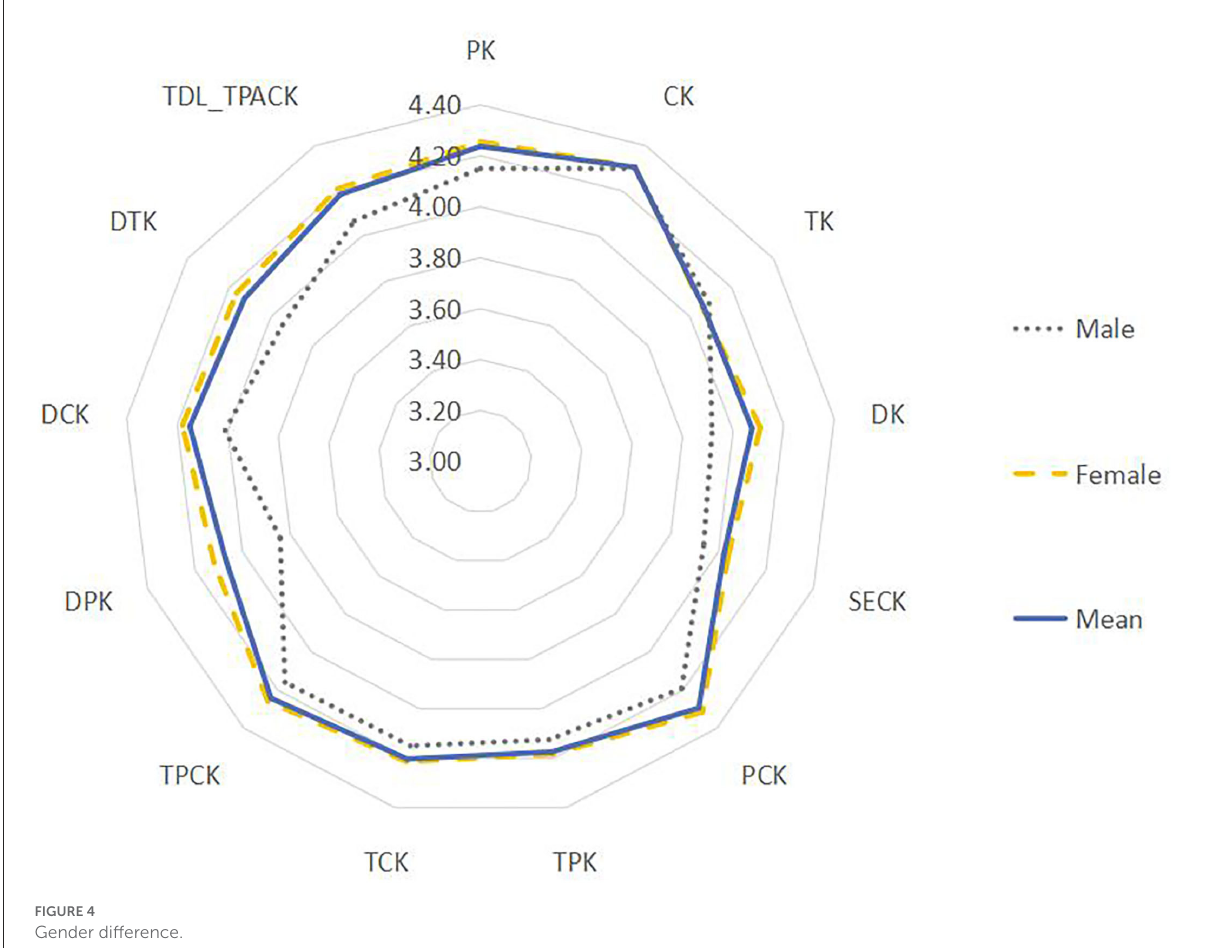
FIGURE4 Gender difference.